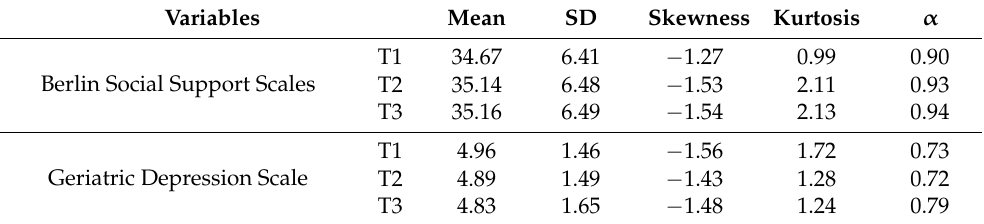
Table 1. Study variables and descriptive statistics at recruitment, 1 and 2 years thereafter (N =